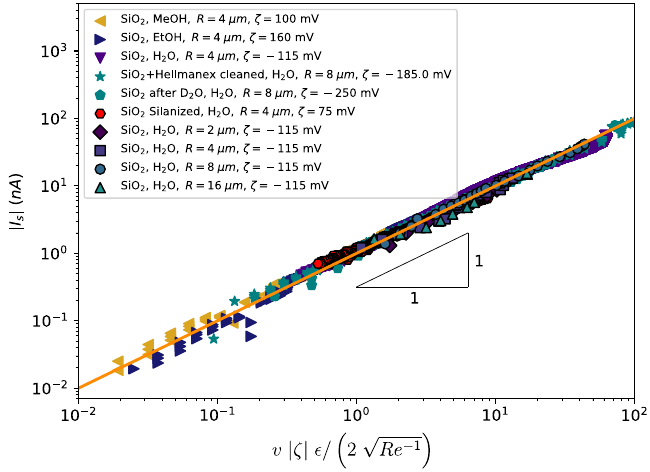
I s Figure 8. Streaming current against the prediction (Eq. 12). The absolute value of the streaming current, , | | plotted against the prediction, for different flow rates, nozzle sizes, liquids and surface treatments. A negative zeta potential in this case indicates a positively charged jet and vice versa. When anhydrous ethanol (EtOH) or methanol (MeOH) is used, the polarity is opposite that of water. Mixed with water, the zeta potential is however again negative (not shown in the figure). Cleaning the nozzle prior to the measurement with Hellmanex III leads to a more negative zeta potential. When heavy water is sprayed before measuring the streaming current 115 mV to ζ 250 mV. This with normal water, the zeta potential temporarily more than doubles from ζ = − = − indicates some kind of incorporation of deuterium atoms on the surface, or the absorption of deuterium oxide molecules. By applying a silane coating on the silicon dioxide surface with positively charged end-groups, the 75 mV), leading to a negatively charged jet for zeta potential can be reversed ( ζ =